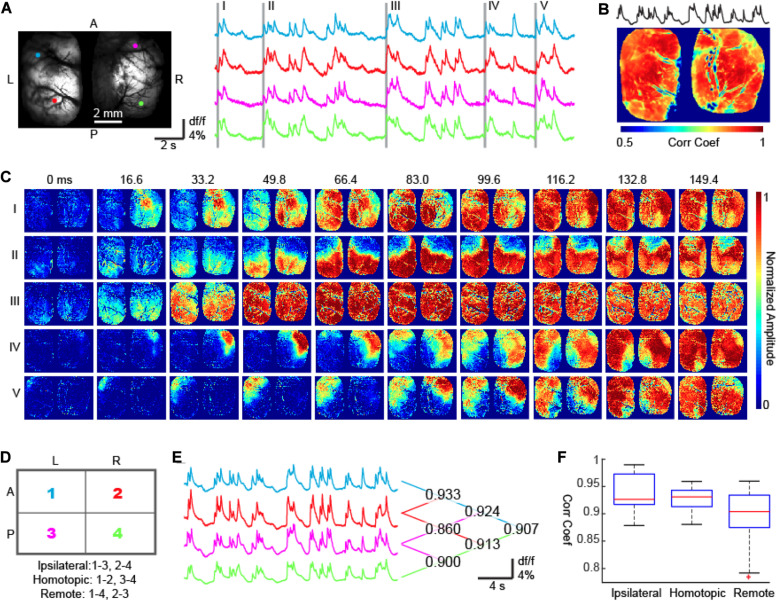
Bi-hemispheric calcium imaging of bursts. (A) The field of view. Four colored circles show 4 ROIs whose calcium signals are shown on the right. The first waves of five bursts are highlighted with gray bars. A, Anterior; P, Posterior; L, Left; R, Right. (B) The correlation coefficient map between the calcium signals recorded from each pixel and the averaged calcium signal of all pixels. Corr Coef: Correlation Coefficient. (C) The onset and propagation of five bursts. Burst I: unilateral onset with non-mirrored propagation. Bursts II and III: bi-hemispheric onsets and mirrored propagation. Bursts IV and V: unilateral onset with mirrored propagation. (D) The bilateral hemispheres were divided into 4 quadrants, which formed 3 categories of quadrant pairs according to their geometric relationships: ipsilateral, homotopic, and remote. (E) Averaged calcium fluorescence of the 4 quadrants. The correlation coefficients between any 2 of the 4 signals were reported on the right. (F) A MATLAB-generated box plot of signal correlation of quadrant pairs. One-way ANOVA test (p < 0.001, F = 29.54, degree of freedom = 27) and Tukey–Kramer post hoc analysis indicates that the correlation coefficient between ipsilateral quadrants and homotopic quadrants are comparable (p = 0.544) and significantly higher than that between remote quadrants (p < 0.001 for both IS and HS).